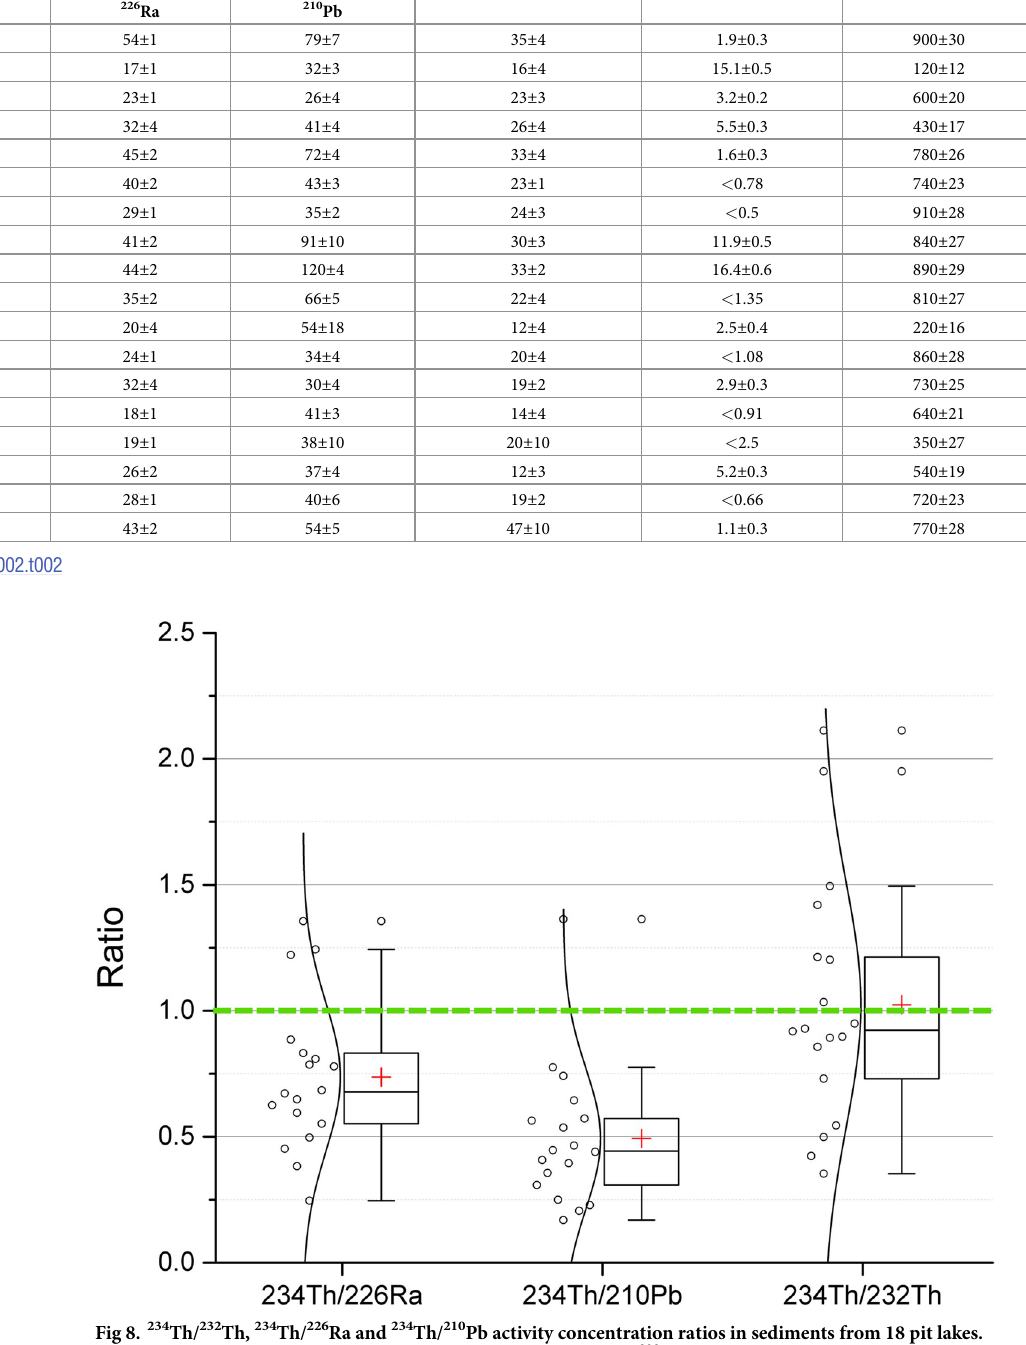
Table 2. Activity concentration in Bq/kg in sediments with uncertainties given as 1 σ . Results were obtained by gamma spectrometry, where 232 Th was assumed to be in equilibrium with 228 Ra (and 228 Ac). Site